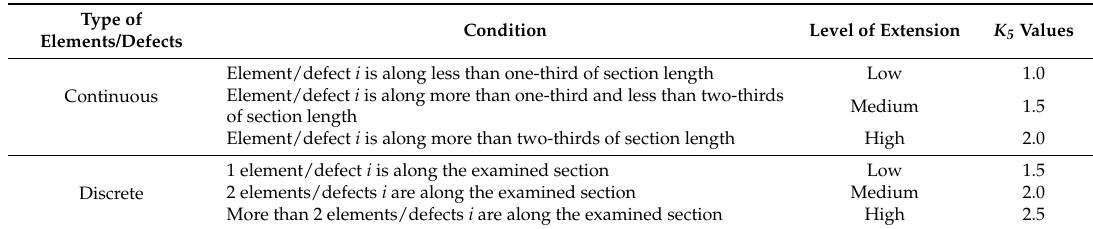
Table 6. Values of the extension factor K 5i